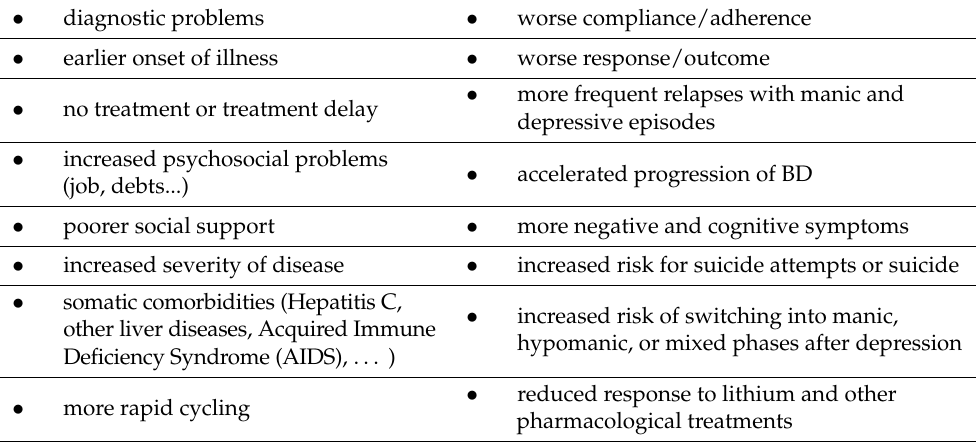
Table 1. Summary of the detrimental impact of comorbid drug abuse on